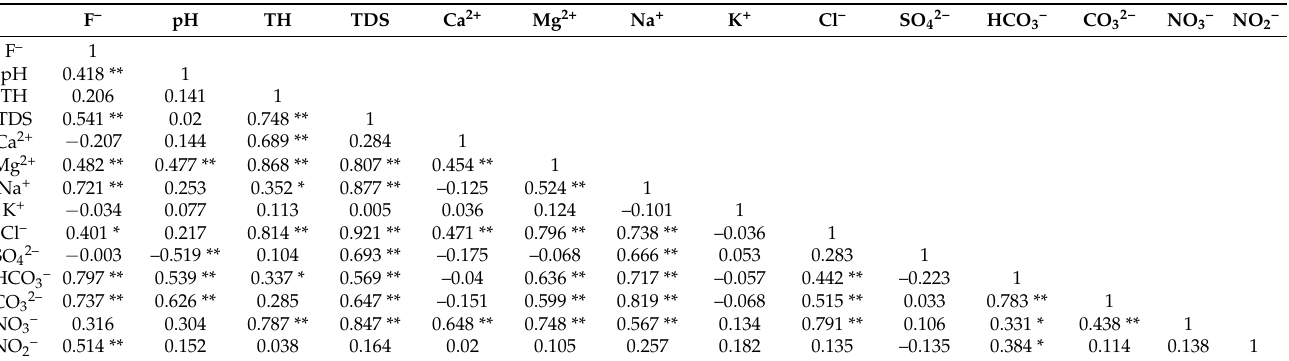
Table 3. Correlation matrix of analyzed physicochemical